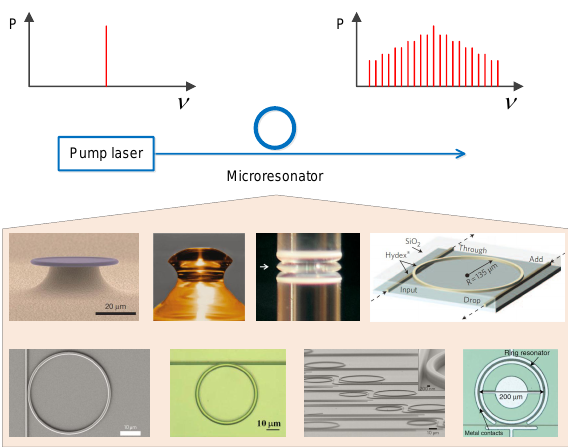
Figure 1: Optical microresonator-based Kerr frequency comb gen- eration. A single pump frequency is converted into a broadband frequency comb by using a high-Q nonlinear microresonator. The inset shows different materials and structures that have been em- ployed for Kerr comb generation. From top left to bottom right: sil- ica microtoroid [17], fluoride crystalline [22], fused quart [19], Hydex glass microring [24], silicon nitride microring [25], aluminum nitride microring [26], diamond microring [27], silicon microring